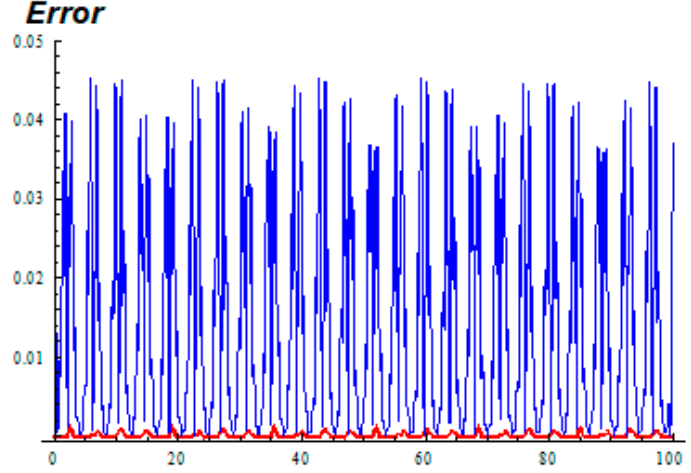
Figure 9. The corresponding absolute errors to approximate solutions using the MDM (red solid line) and RK4 method (blue line) for 0 100 t ≤ ≤ and step-size 0.5 h = .